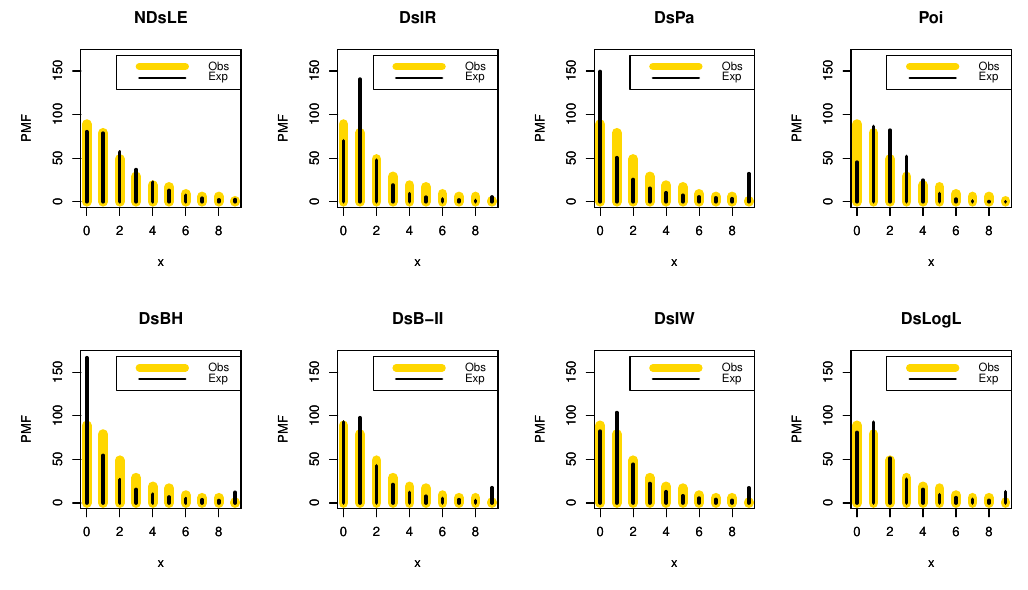
Figure 14. The empirical PMFs plots for data set